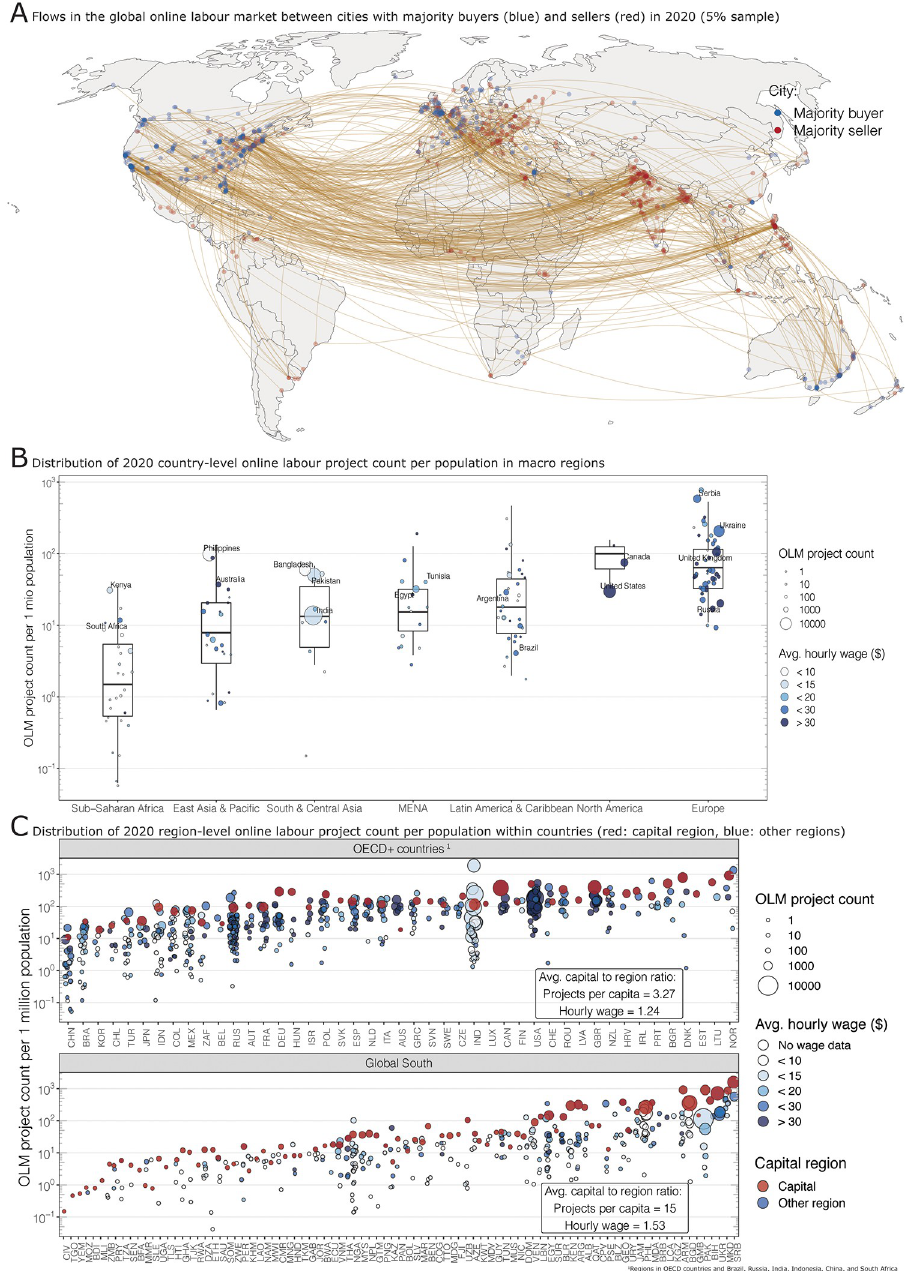
Fig 1. ( A ) Connections between majority buyer (blue) and seller cities (red) in the 2020 platform labour market (5% sample): hotspots of demand are North America, West Europe, and Australia; platform workers in Eastern Europe, South Asia and the Philippines conduct most remote jobs. ( B ) Distribution of 2020 online labour (OLM) project count per capita (y-axis) in countries (dots), grouped by global macro regions (x-axis): globally, platform activity varies by several orders of magnitude; Europe and North America show the highest levels of participation, and the highest average wages (dot colour); most countries in the Global South participate only marginally in the remote labour market with low wages and less than 10 projects per one million population, with the exception of the Philippines, Bangladesh, Pakistan, and India. ( C ) Online labour distribution within countries in OECD+ and Global South countries: participation varies vastly within countries with most capital regions (red) hosting the largest platform worker communities per country; the imbalance is particularly pronounced in the Global South where the capital region hosts, on average, 15-times as many projects per capita than other regions in the